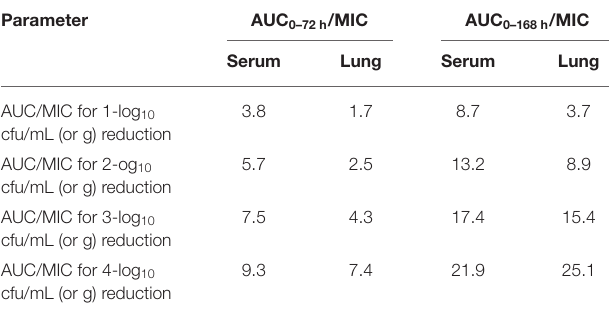
TABLE 4 | The single dosage values (mg/kg) calculated from the ratios of AUC/MIC against H. parasuis . Parameter AUC 0–72h /MIC AUC 0–168h /MIC Serum Lung Serum